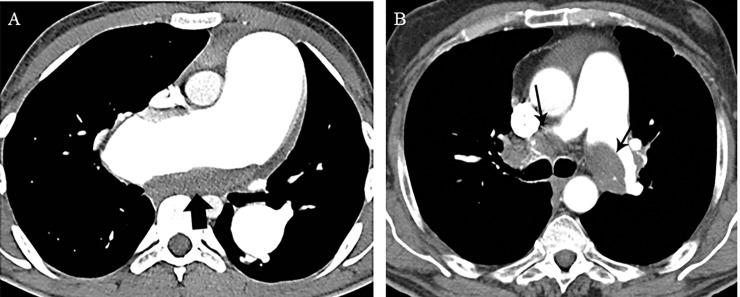
Vascular signs of chronic PE in patients with CTEPH.(A) Axial MDCTA image shows wall-adherent thrombus (arrow) in the pulmonary artery trunk and the right main pulmonary artery. (B) Axial MDCTA image shows wall-adherent thrombus (arrows) in the right and left pulmonary arteries.